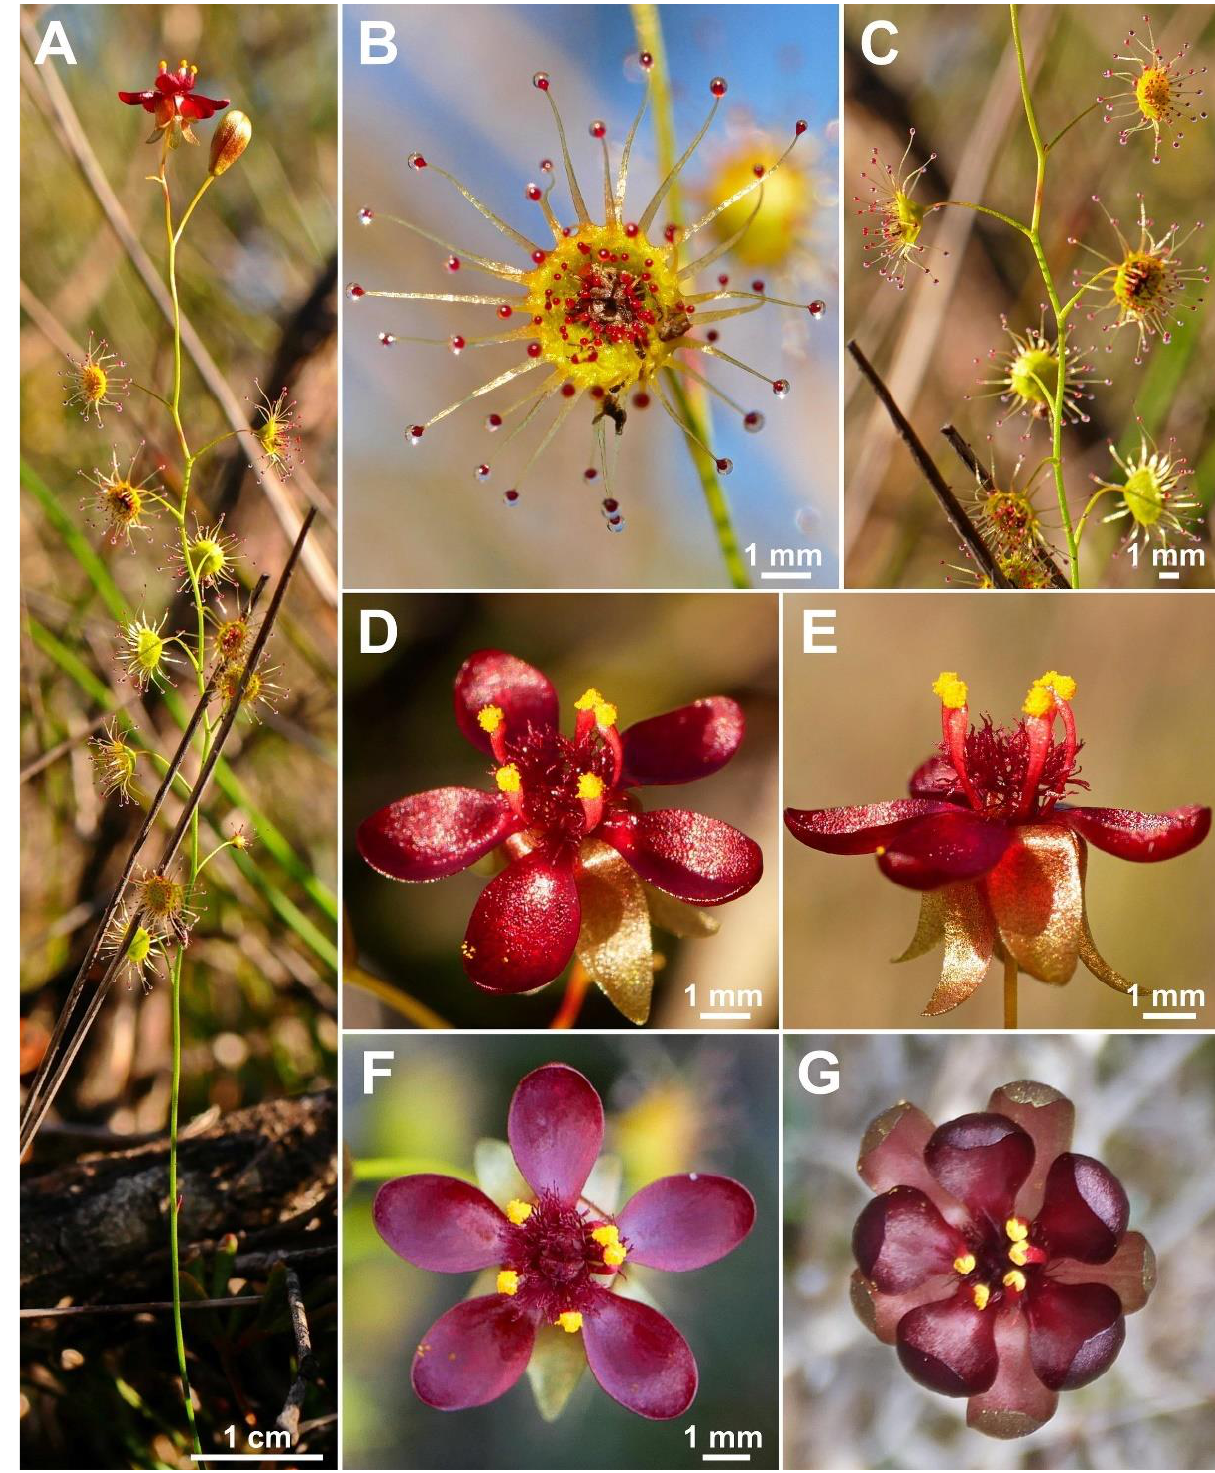
Figure 11. Drosera koikyennuruff T.Krueger & A.S.Rob. ( A ) habit; ( B ) lamina; ( C ) stem and leaves; ( D ) flower in bright sunlight; ( E ) flower, lateral view; and ( F , G ) flowers in diffuse light. ( A – F ) from Stirling Range National Park, Western Australia, 2 July 2022; images by T. Krueger. ( G ) from near Woogenellup, Western Australia, July 2021; image by P. Luscombe. Description: Tuberous perennial herb, ca. 15 cm tall above ground including inflores- cence. Tuber not seen. Stem (epigeous part) erect, self-supporting, simple, terete,